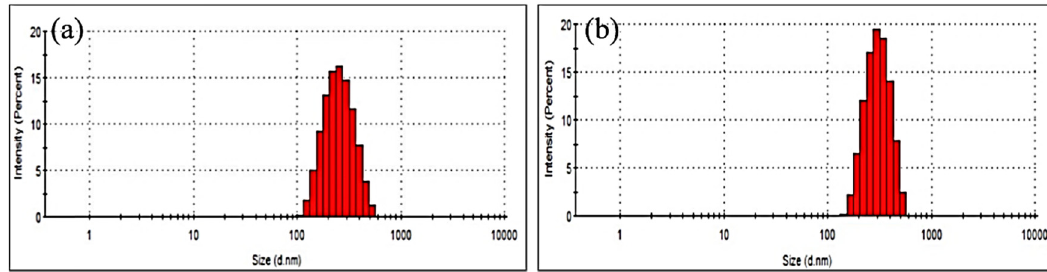
Figure 2: Particle size distribution of ( a ) ZnO Chem and ( b ) ZnO SMEAF